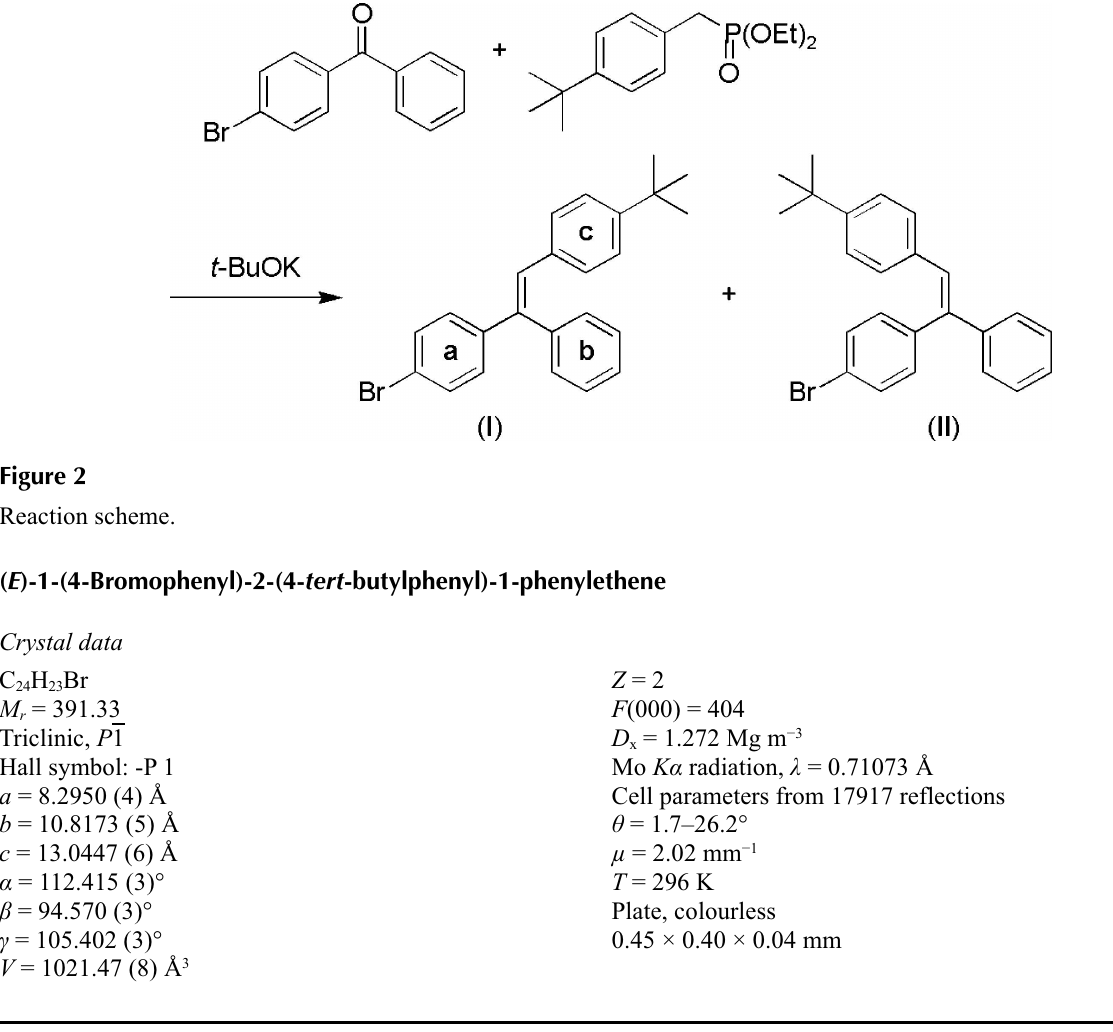
Figure 1 The molecular structure of (I), showing 50% probability displacement ellipsoids and the atom-numbering scheme. For reasons of clarity, the H atoms have been omitted and only the major component of the disordered tert -butyl residue is shown.